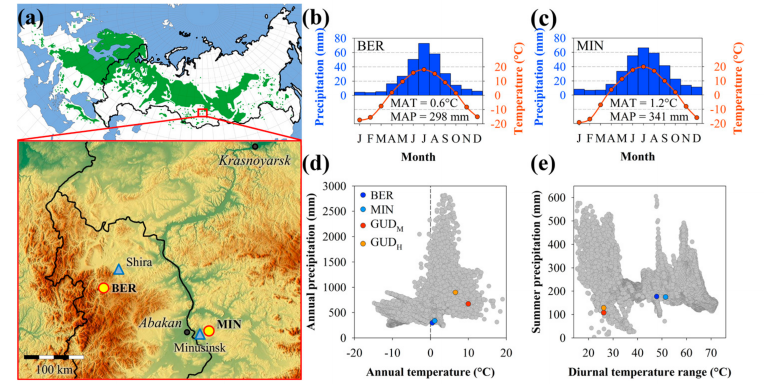
Figure 1. Geographical location and climatic characteristic of the sampling sites in the forest–steppe of Central Siberia. ( a ) P. sylvestris distribution (green shading; [39]) and location of the study area ( top ) and distribution of pine stands ( bottom ). Circles mark positions of the sampling sites and triangles denote Minusinsk and Shira meteorological stations used in the analyses. ( b , c ) Climate diagrams corresponding to northern (BER) and southern (MIN) sites. The primary y -axis indicates monthly precipitation (bars) and the secondary y -axis monthly mean temperature (lines). Average monthly values of climate factors were estimated based on the climate data from the nearest meteorological stations for the period 1940–2014. The mean annual temperature (MAT) and mean annual precipitation (MAP) are given for each site. ( d , e ) Autoecology diagram of P. sylvestris distribution with sites used in the analyses depicted as colored circles: blue—BER (cold–dry site), light blue—MIN (cold–moist), red—GUD M (warm–dry) and orange—GUD H (warm–moist) (see Section 2.6. for further details on GUD sites). The species range is derived from the EUFORGEN distribution map (http://www.euforgen.